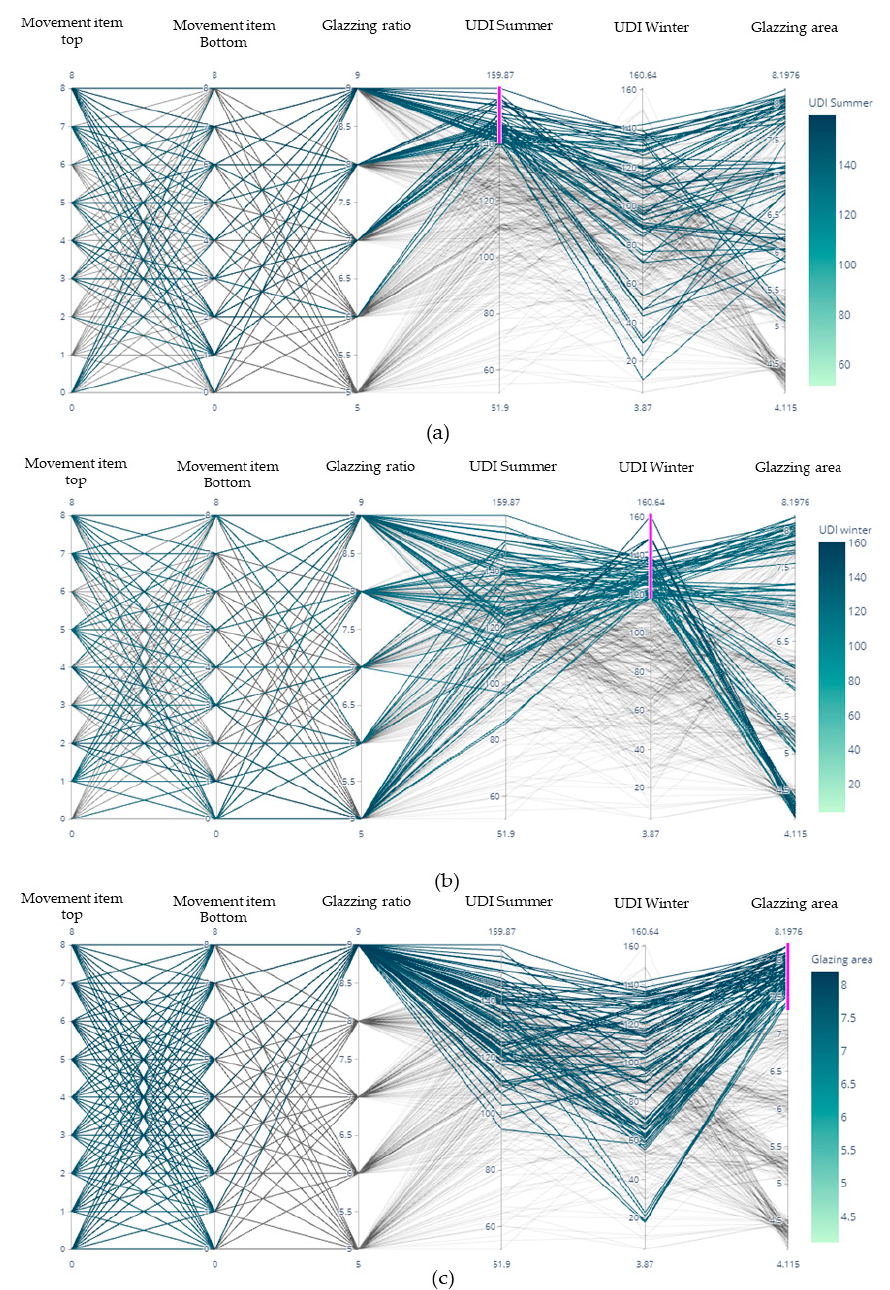
Figure 20. Parallel coordinate plots for daylight iteration: ( a ) relation to highest UDI summer; ( b ) relation to highest UDI winter; ( c ) relation to highest glazing area.